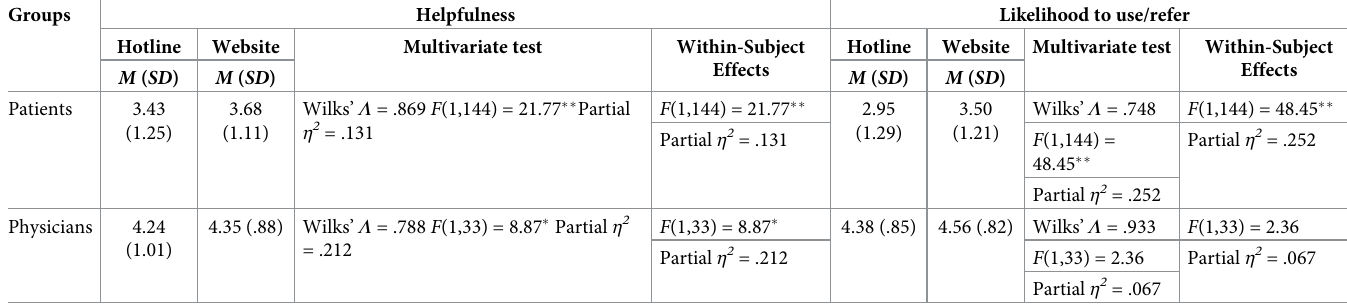
Table 7. Repeated measures ANOVA to investigate patients’ and physicians’ responses to hotline and website trauma resource centre.